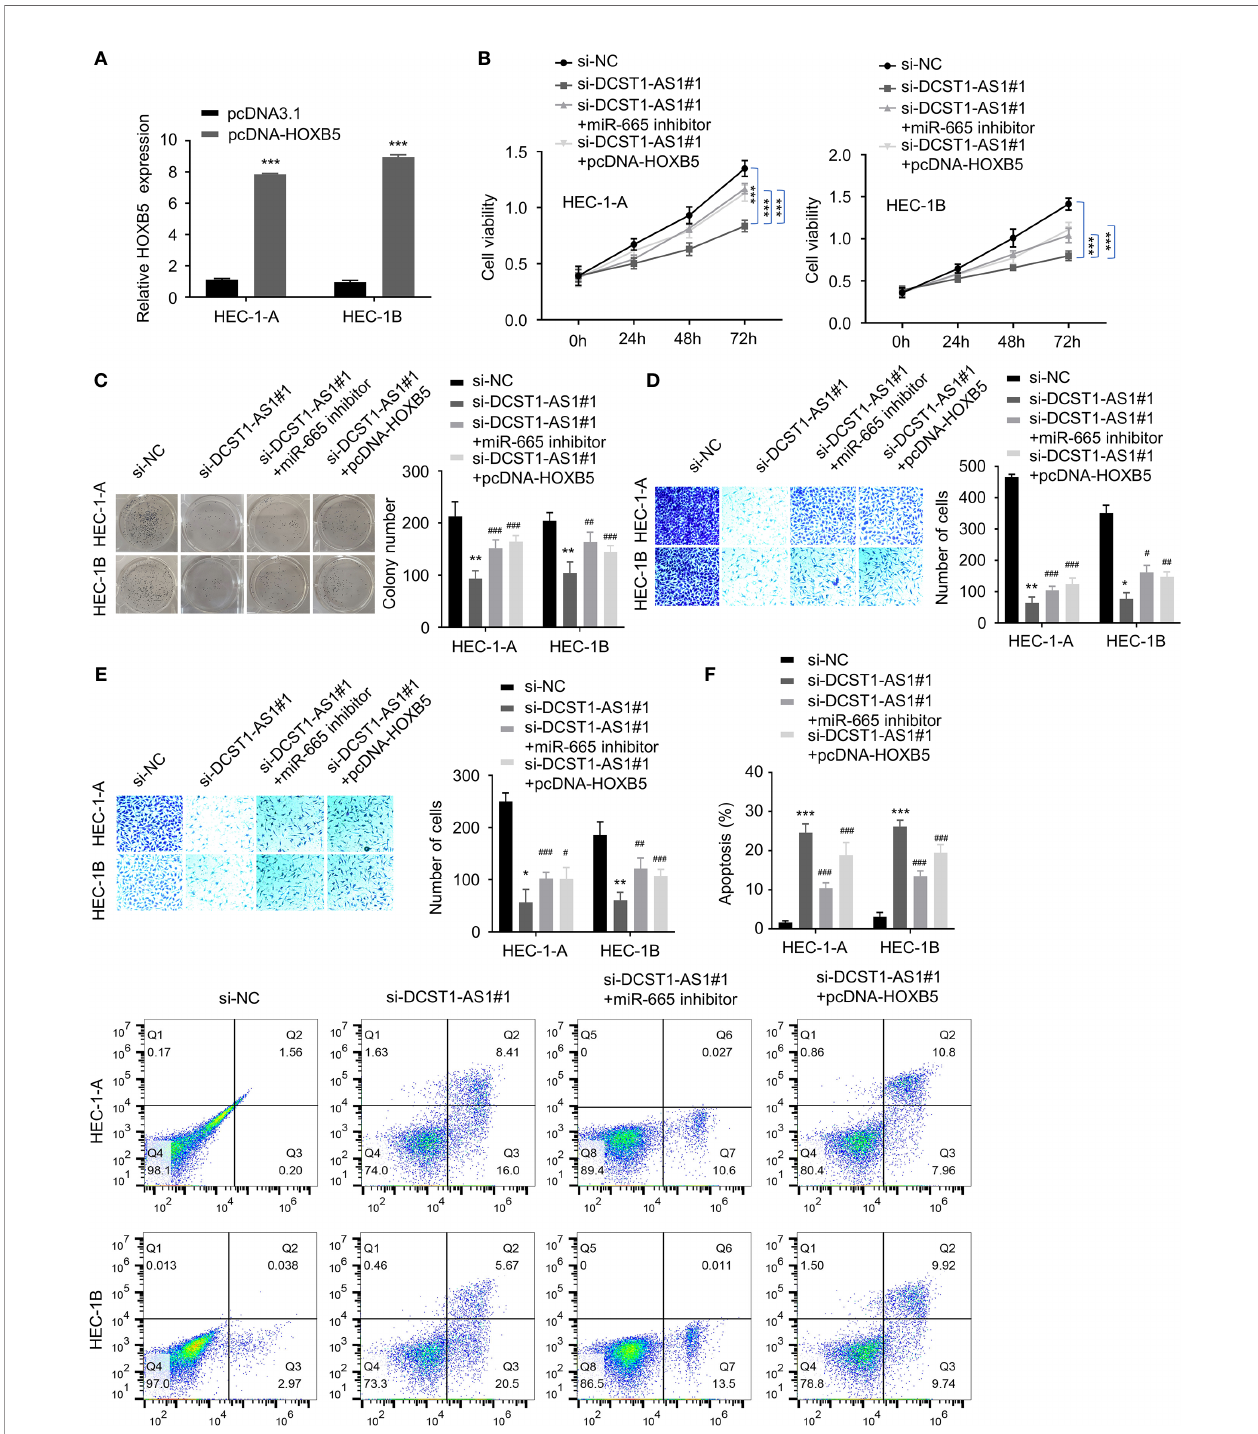
FIGURE 6 | LncRNA DCST1-AS1 promotes EC progression via the miR-665/HOXB5 signaling. (A) qRT-PCR analysis of HOXB5 expression in EC cells transfected with HXOB5 overexpression plasmid or control plasmid. (B) CCK-8 assay showed that either miR-665 inhibition or HOXB5 overexpression rescued EC cell proliferative reduced by DCST1-AS1 knockdown. (C) Colony formation assay of EC cells transfected as indicated. (D, E) Transwell migration and invasion assay showed that either miR-665 inhibition or HOXB5 overexpression rescued EC cell migration (D) and invasion (E) that was suppressed by DCST1-AS1 depletion. (F) HEC-1A and HEC-1B cells were transfected as indicated, and cell apoptosis was determined by FACS analysis. * P < 0.05, ** P < 0.01, *** P < 0.001. # P < 0.05, ## P < 0.01, ### P < 0.001, compared with si-DCST1-AS1#1